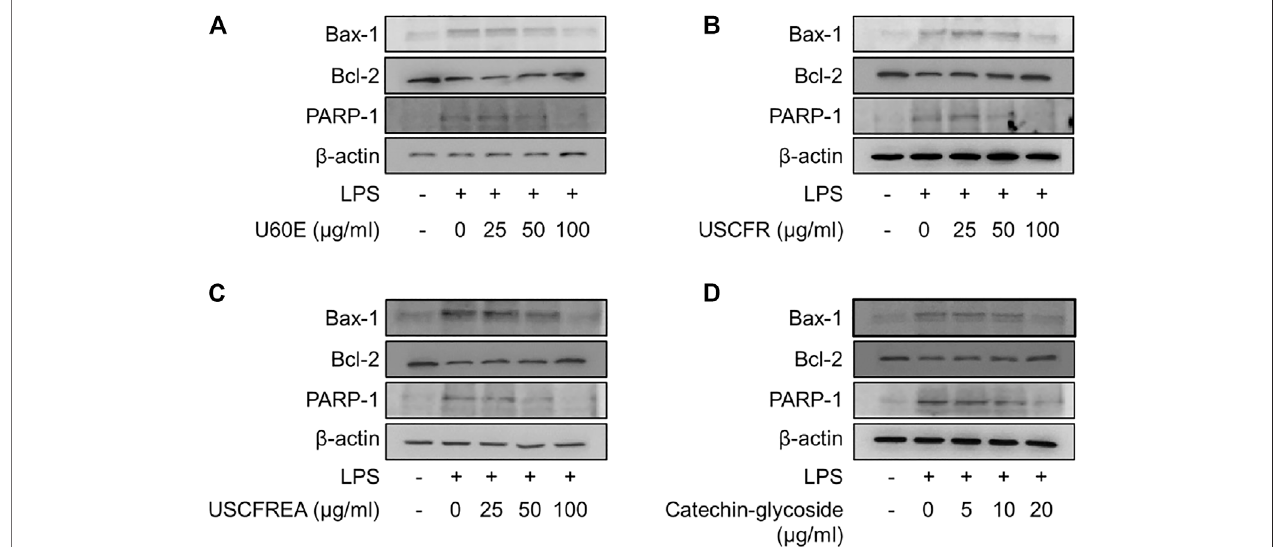
FIGURE 6 | Inhibition effects of U60E, USCFREA, USCFR, and catechin-glycoside – rich fraction on LPS-induced apoptosis signaling in U937 cells. Cells were treatedwithLPS(1 μ g/ml)inthepresenceorabsenceoftheindicateddosesof (A) U60E, (B) USCFR, (C) USCFREA,and (D) catechin-glycoside – richfraction.Lysedcell extracts were analyzed by Western blotting using the indicated antibodies. U60E, USCFREA, USCFR, and catechin-glycoside – rich fraction were pretreated for 10 min before LPS treatment. The Western blot is representative of three independent experiments.